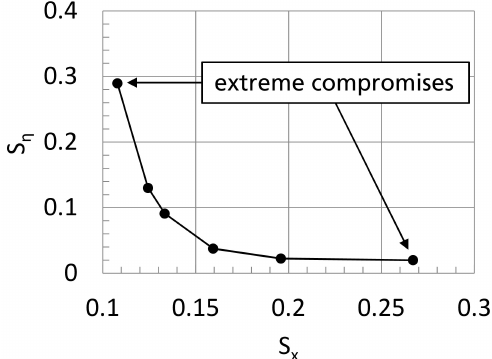
Figure 2. Pareto frontier of the multi-criteria optimization problem for adjustment of the electrochem- ical reactor model to measured data displayed in the objective space spanned by the sums S x and S η over all normalized and squared differences between the measured values and the values predicted by the model for the product purity x and the Faraday efficiency η . The plotted points correspond to the data in Table 3. Table 3. Results including the respective weighting factors w x , w η for the Pareto points from the multi-criteria optimization problem for adjustment of the electrochemical reactor model to measured data. The points are plotted in the objective space in Figure